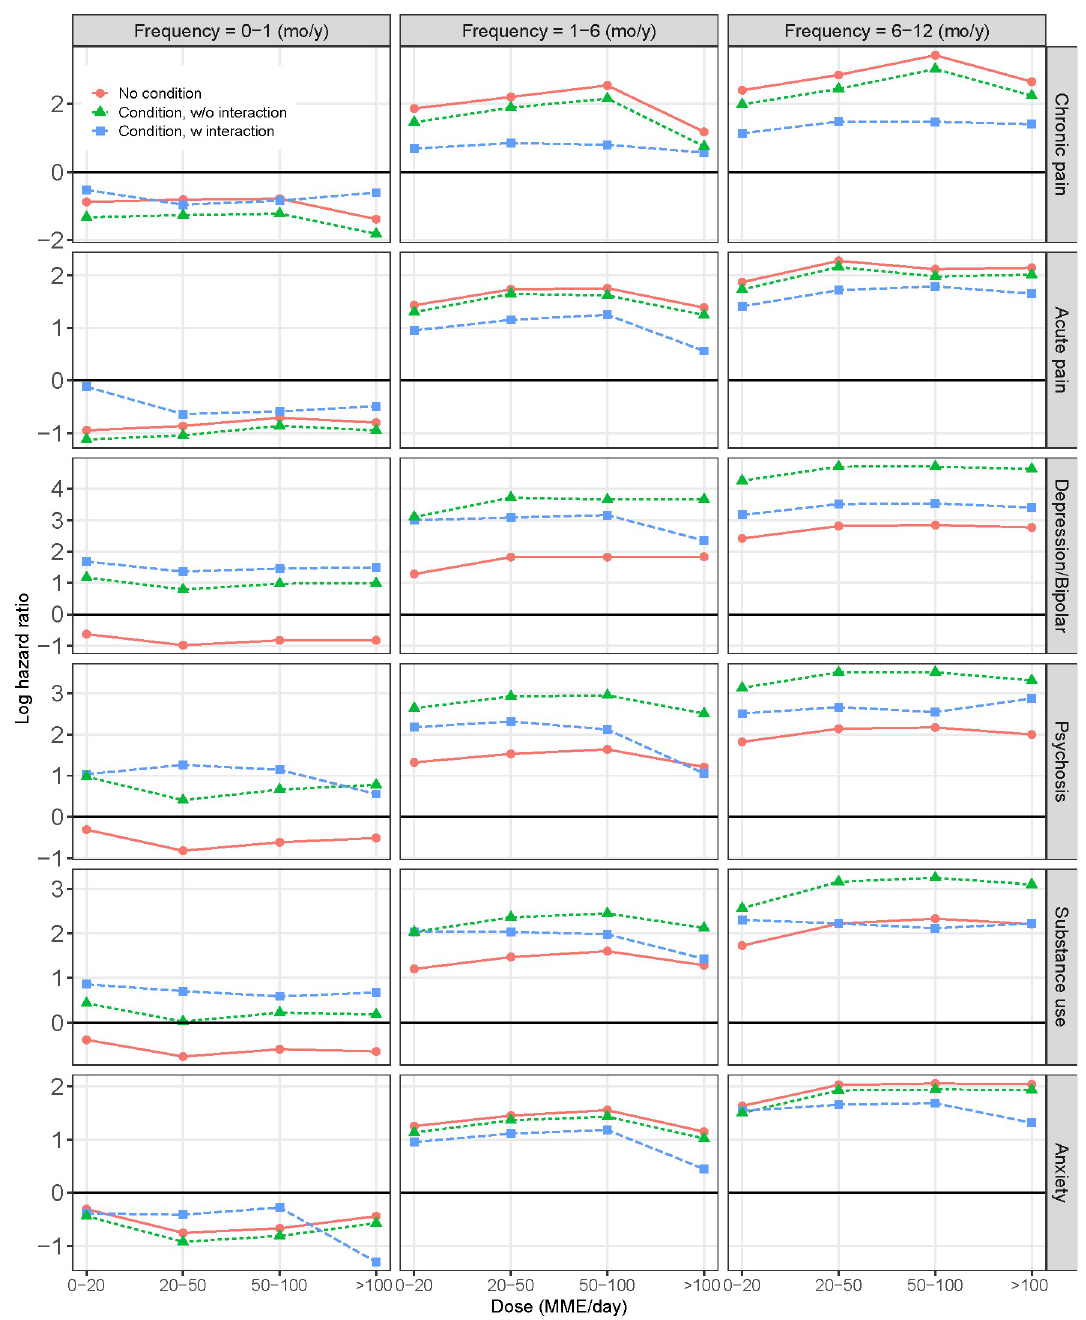
Fig 1. Interaction effects involving medical/psychiatric conditions and opioid use (frequency, dose) on risk of suicide attempt. Cancer, neuropathy, and PTSD were not included as their interactions with opioid use were not statistically significant. The figure is derived from models that include both main effects for opioid use and the conditions as well as the interaction term (opioid use X a particular condition). The difference between the parallel red and green lines indicates the main effect of a particular condition, while the discrepancy between the green and the blue lines indicates the interaction, i.e. the existence of medical or psychiatric conditions affects the effect of opioid usage on suicide attempt risk.